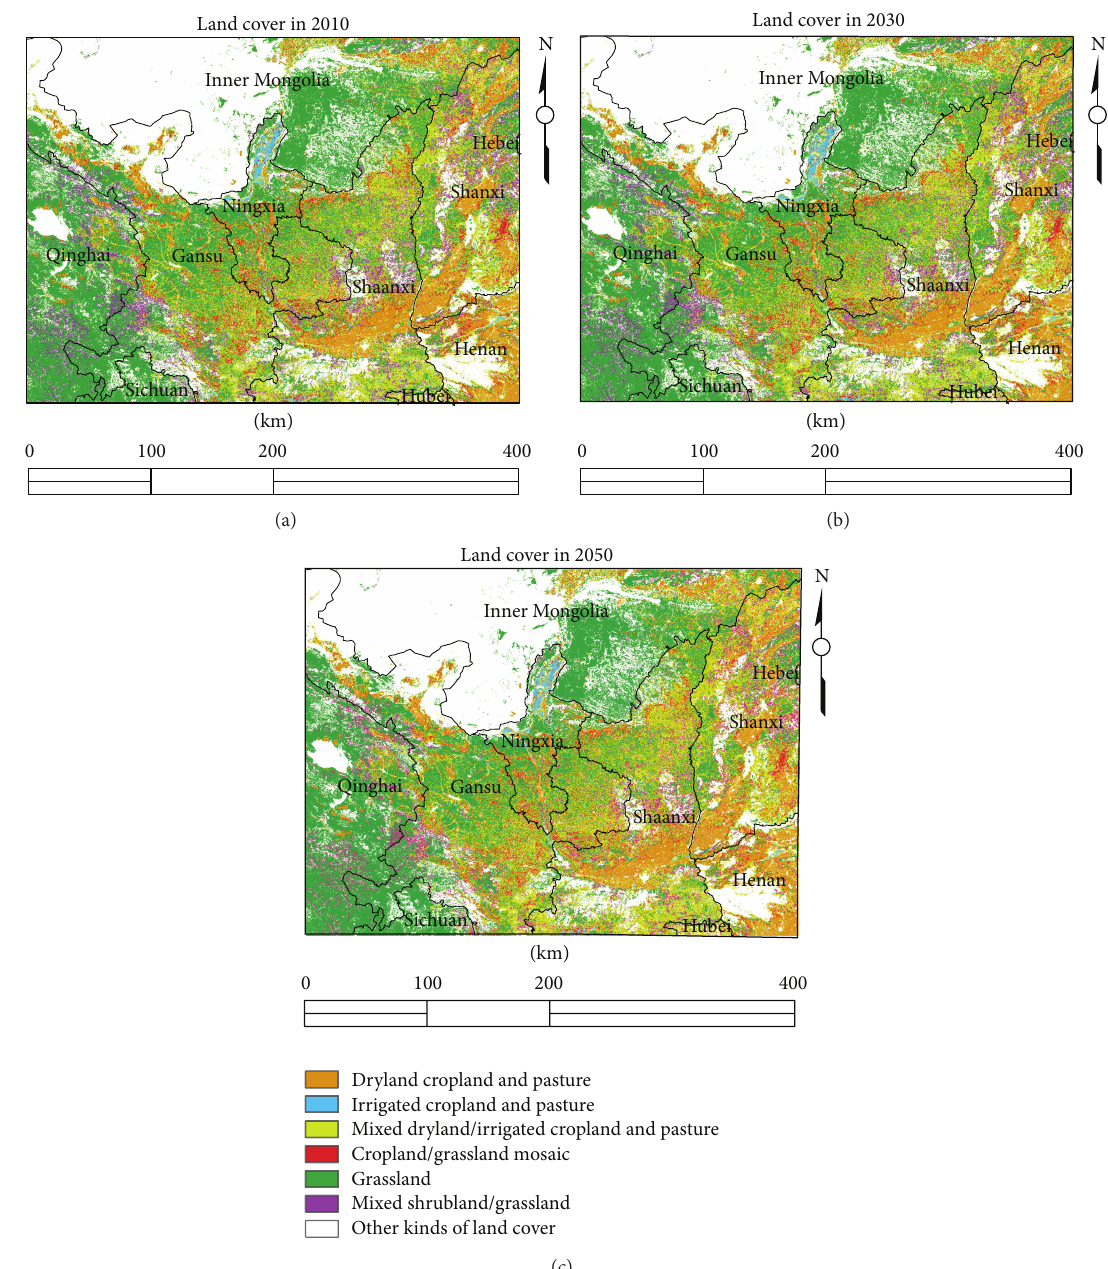
Figure 2: Spatial distribution of grassland from 2010 to